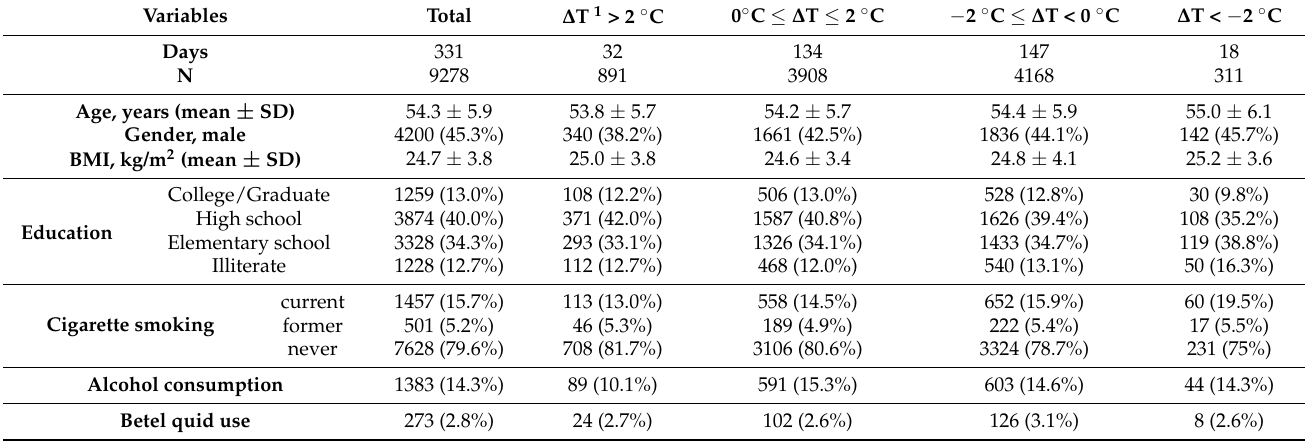
Table 2. Counts and percentage of WBCs by different value of ∆